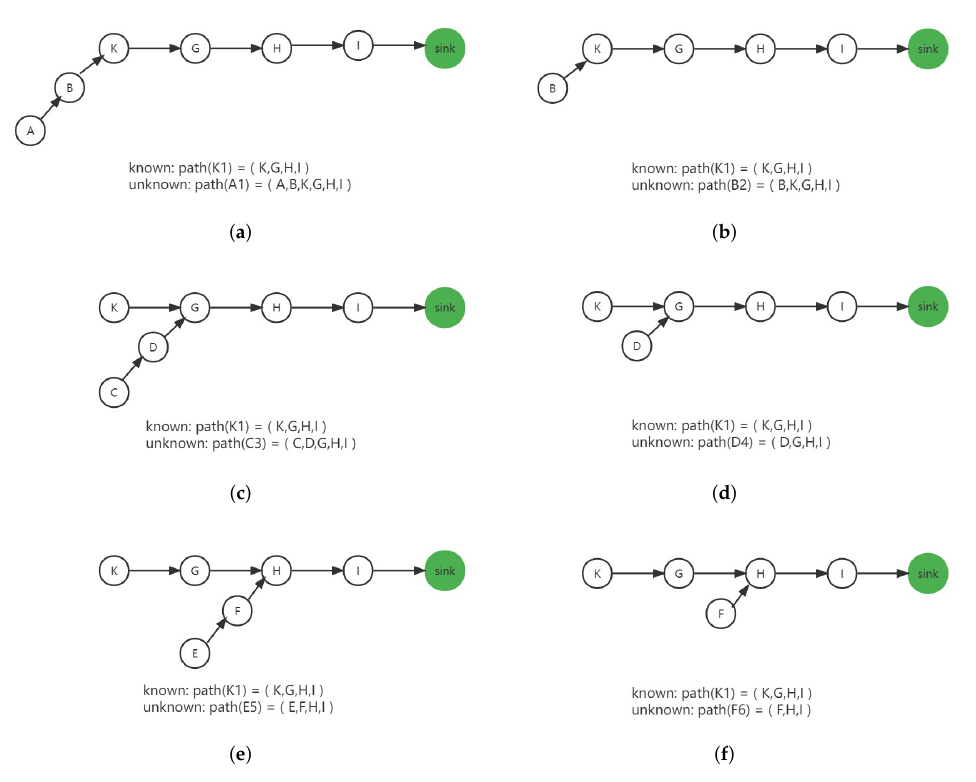
Figure 5. The correlations of paths. ( a ) Case 1. ( b ) Case 2. ( c ) Case 3. ( d ) Case 4. ( e ) Case 5. ( f ) Case